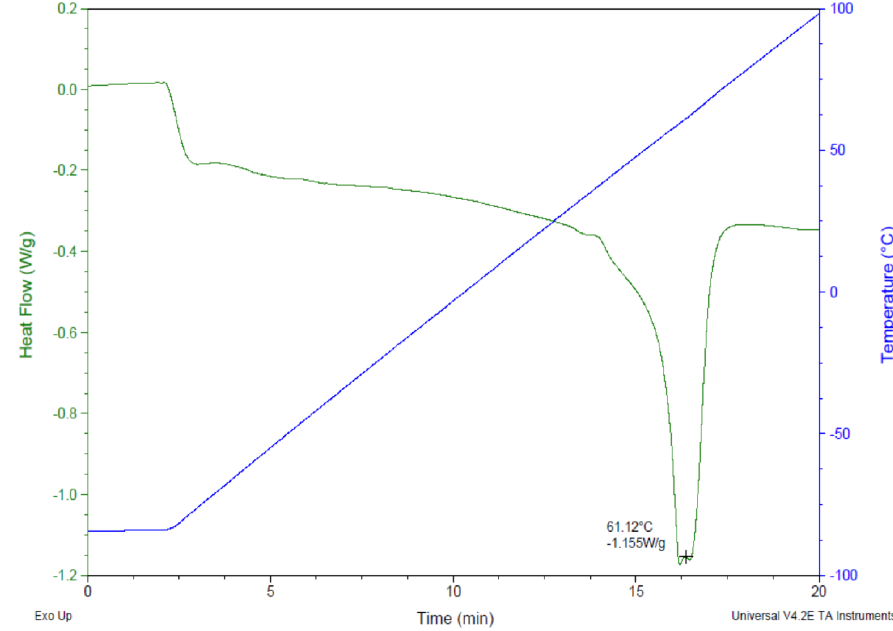
Figure 2. Differential scanning calorimetry (DSC) of polycaprolactone displaying the melting temperature of 61.12